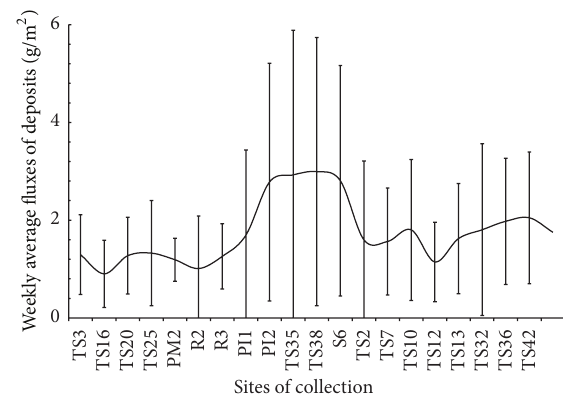
Figure 5: Variation of weekly average fluxes (and their standard deviations) of deposits particles.